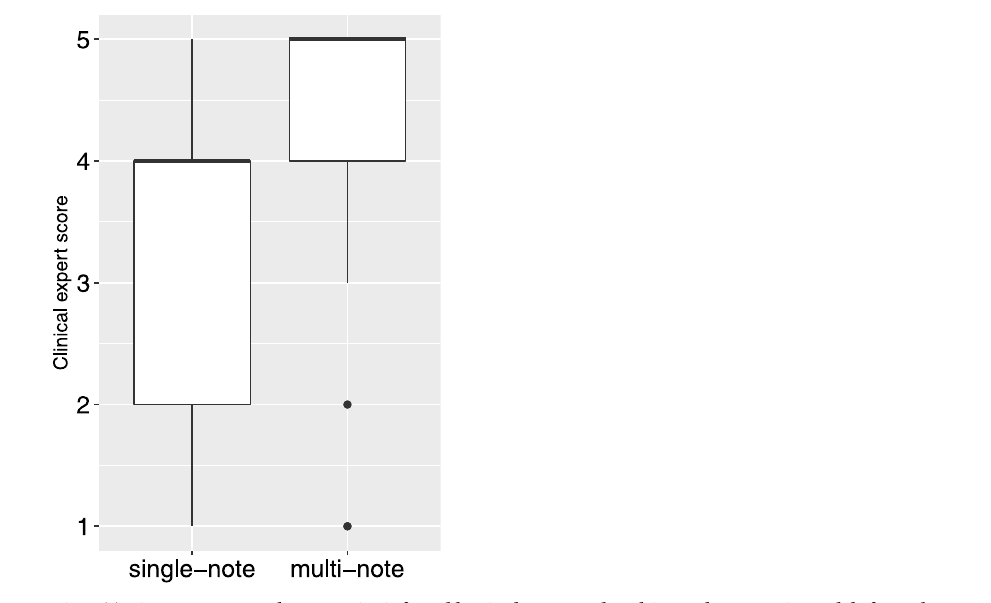
Fig 4. Topic scores over 50 latent topics inferred by single-note and multi-note latent topic models from the 17,000 clinical notes. The horizontal lines in the box represent the median and the box represent the range between 25% and 75% quartile of the